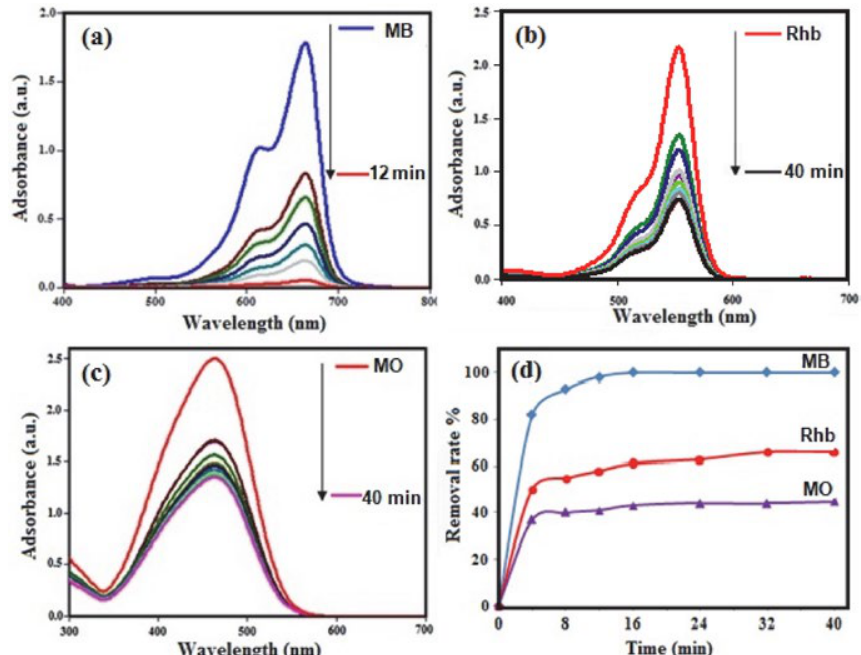
Figure 9. The adsorption capability of GO/Co MB, RhB, and MO dyes.